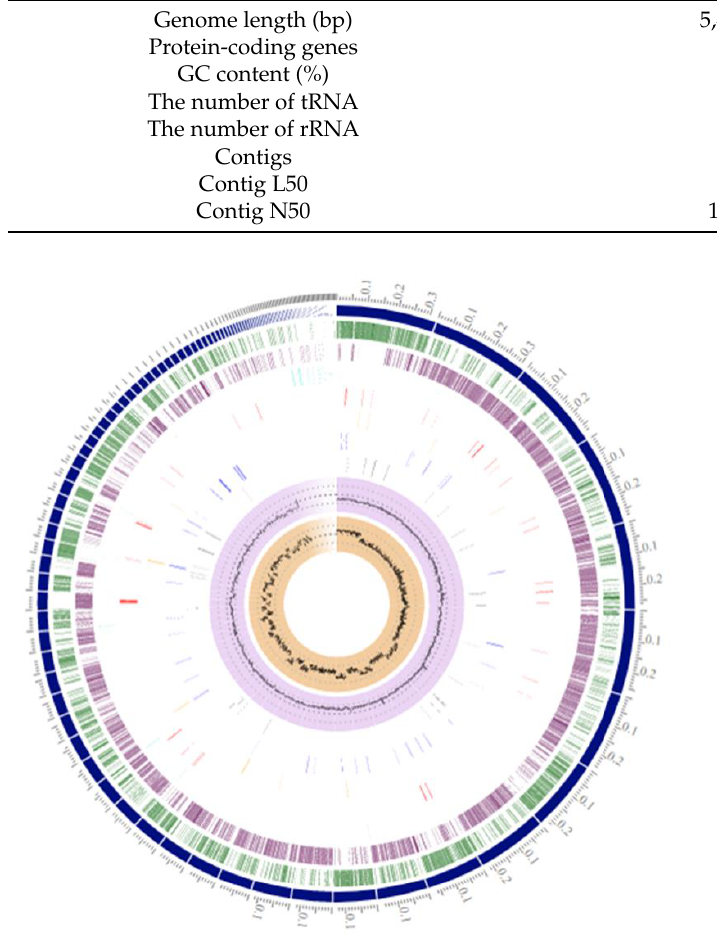
Figure 2. Circular representation of the Bacillus sp. B87 draft genome. Circular genome visualization was generated using the circular viewer of PATRIC. Outer to center: contigs, forward CDS, reverse CDS, non-CDS features, AMR genes, VF Genes, transporters, and drug targets. The two inner tracks are GC content and GC skew.